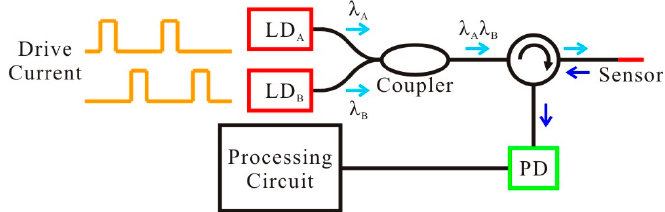
Figure 5. System configuration of the proposed fast measurement system with a PMCFFI sensor.